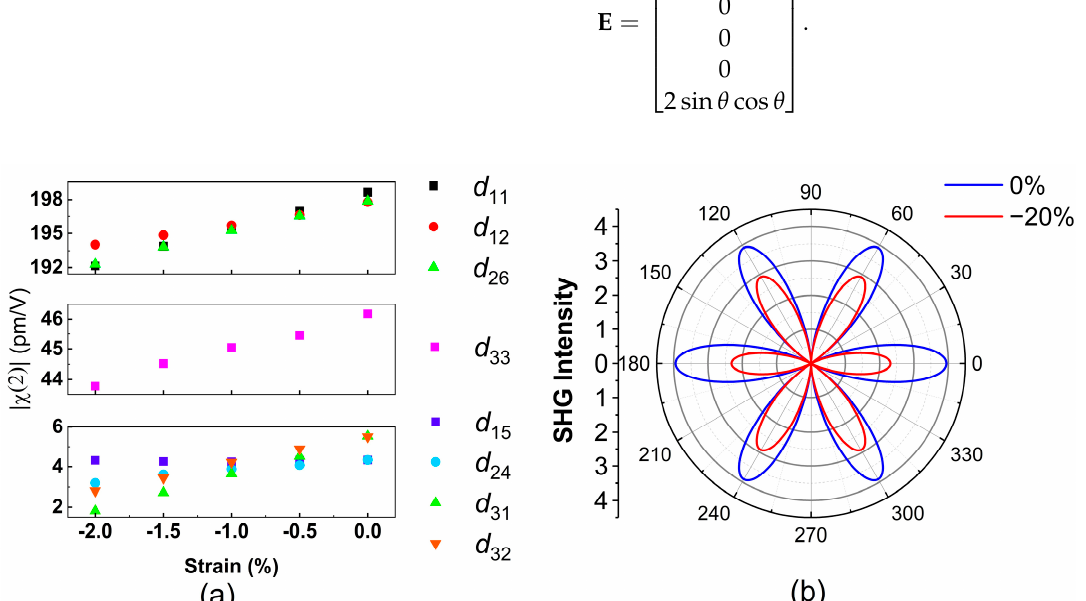
(cid:12) (cid:12) ( 2 ) (cid:12) (cid:12) (cid:12) χ (cid:12) components at photon energy 1.55 eV at different uniaxial ( 2 ω ) pattern under 0% and − 20% strain derived from the calculated (cid:107)